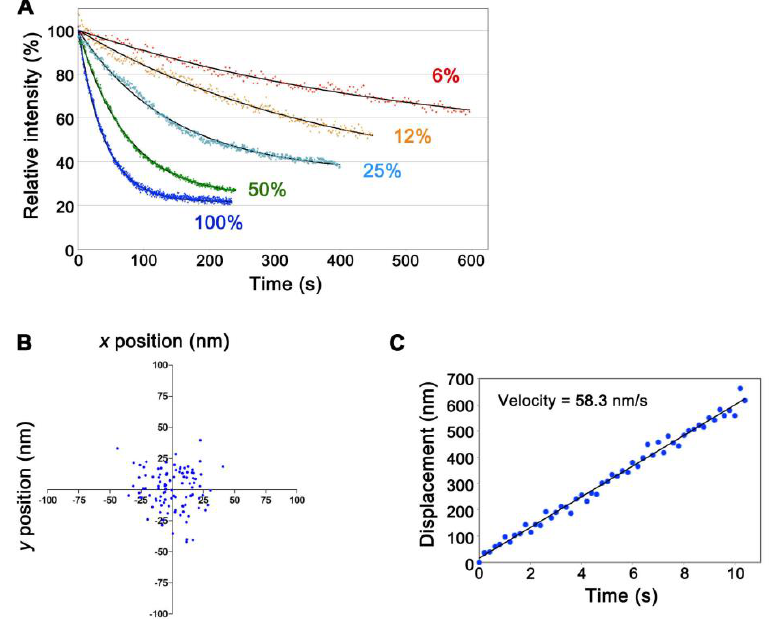
Figure 2. Characterization of CF680R-actin in live XTC cells. ( A ) Photostability of CF680R-actin using excitation light with the 75 W xenon illumination system in live cells. The excitation light used was full (100%) or attenuated to 50%, 25%, 12% or 6% as indicated. Black lines show the single-exponential curve fitted to the data. The data shown are representative of three independent experiments; ( B ) Dispersion of the central position of the immobile glass-bound CF680R-actin speckle acquired with a 200 ms exposure time and a full 75 W xenon excitation (fast-tracking images, 100 frames). The standard deviations of the centroid positions in one direction are 16.3 nm for the x -axis and 16.0 nm for the y -axis. The data shown are representative of the data from three independent experiments; ( C ) Displacement plot of the central position of CF680R-actin in lamellipodia in the series of fast-tracking images (50 frames). Note that CF680R-actin speckles moved with the retrograde actin flow in lamellipodia. The velocity of the CF680R-actin speckles was calculated from a linear fit. The data shown are representative of the data from three independent experiments.